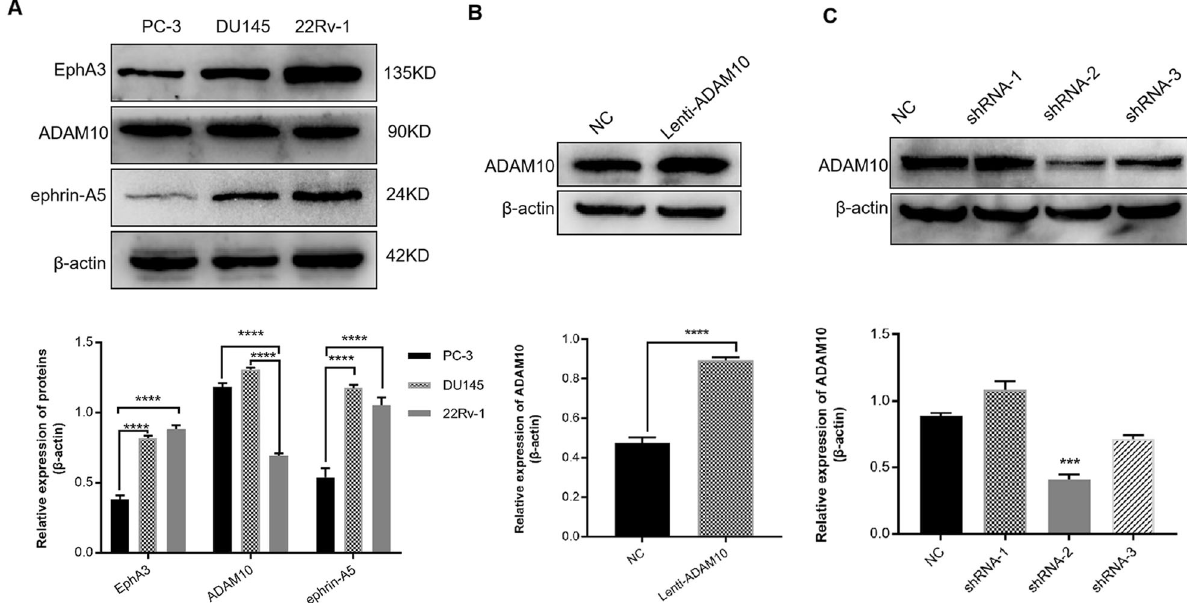
Fig. 1 Measurement of ADAM10, EphA3 and ephrin-A5 proteins levels and construction of stable cell lines. A The expression of three proteins in PC-3, DU145, 22Rv-1 cell lines were detected by Western blotting (top), quanti fi cation of protein expression was normalized to β -actin(bottom). B Western blotting con fi rmed the overexpression of ADAM10 in DU145 cell line (top), quanti fi cation of protein expression was normalized to β -actin(bottom). C Western blotting con fi rmed the knockdown of ADAM10 in DU145 cell line (top), quanti fi cation of protein expression was normalized to β -actin(bottom). * P < 0.05, ** P < 0.01, *** P < 0.001, **** P <